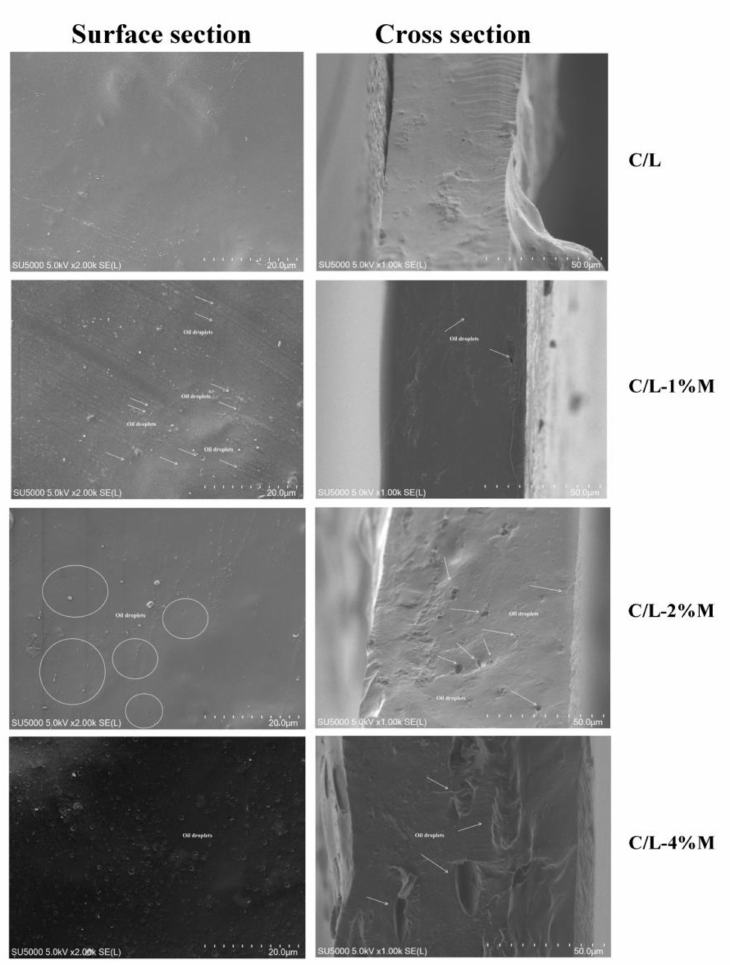
Figure 4. Scanning electron microscope patterns of carboxymethyl chitosan/locust bean gum and carboxymethyl chitosan/locust bean gum/ Melissa officinalis L. essential oil films. (C/L: coated